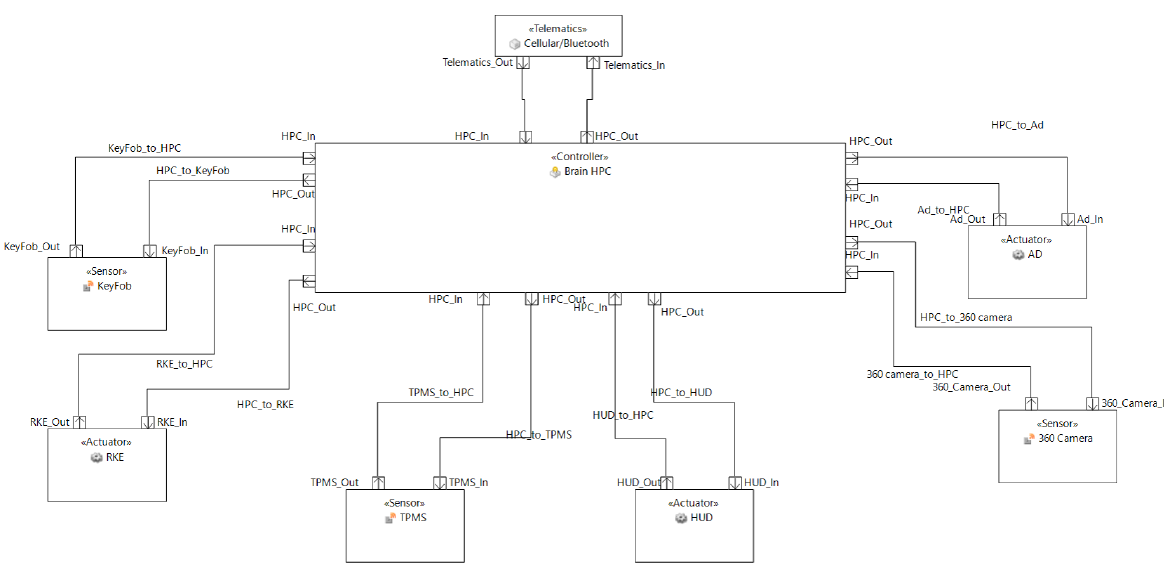
Figure 12. Realization of One-Brain Architecture in Medini Ansys Medini